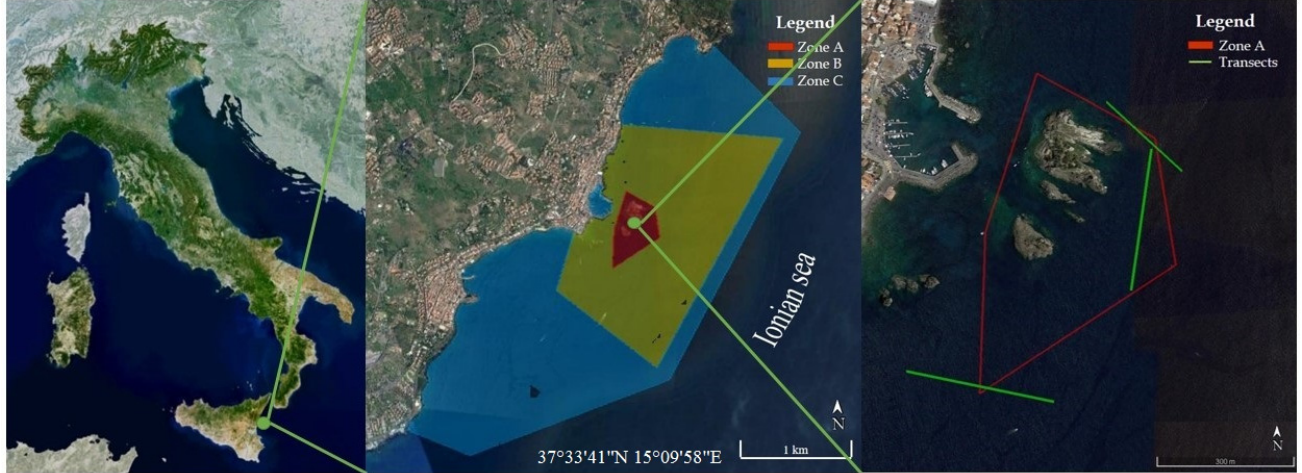
Figure 1. Geographical location of the study area along the Ionian coast of Sicily; location of the Marine Protected Area (MPA) Isole Ciclopi with the indication of the zonation pattern; detail of the zone A showing in green the Remotely Operated Vehicles (ROV) transects (source: Google Earth).